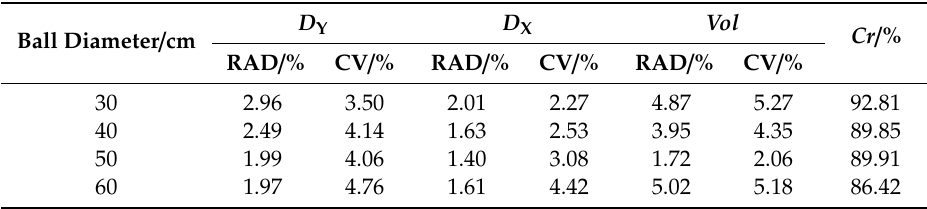
Table A1. Analysis of morphological measurements of SSBs that di ff er in diameter.